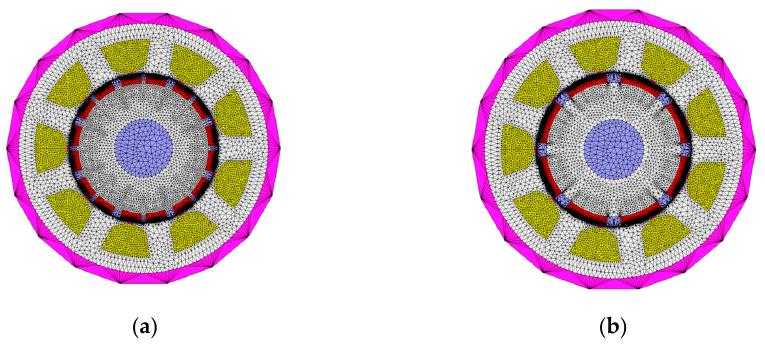
Figure 9. The meshed models. ( a ) DHPCM-SPMPs. ( b ) CPMM.